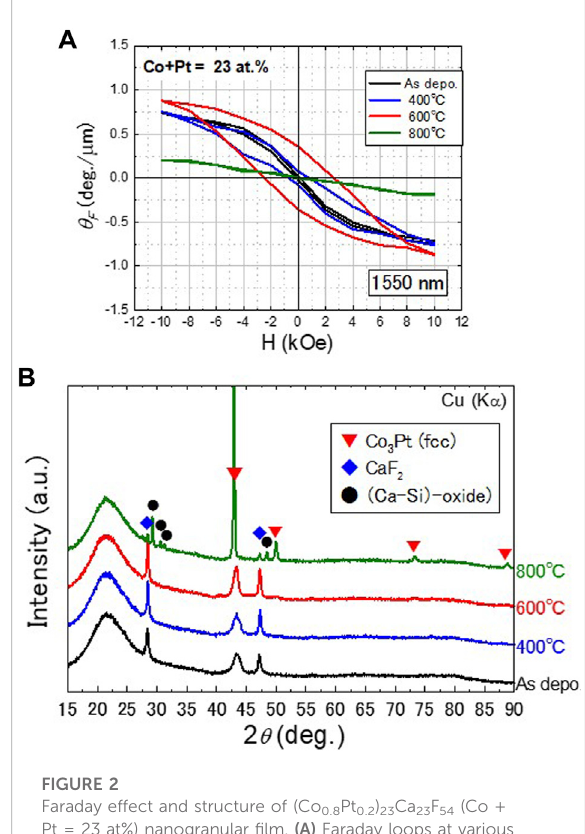
annealing temperatures. (B) XRD patterns with different annealing